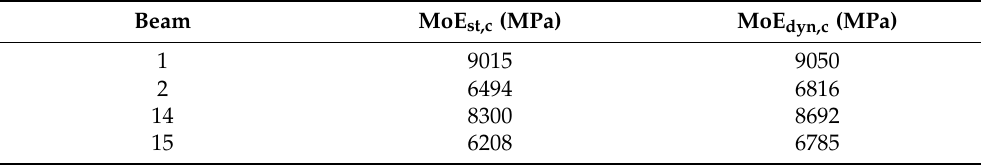
Table 3. MoE st,c and MoE dyn,c comparison for the four beams tested to